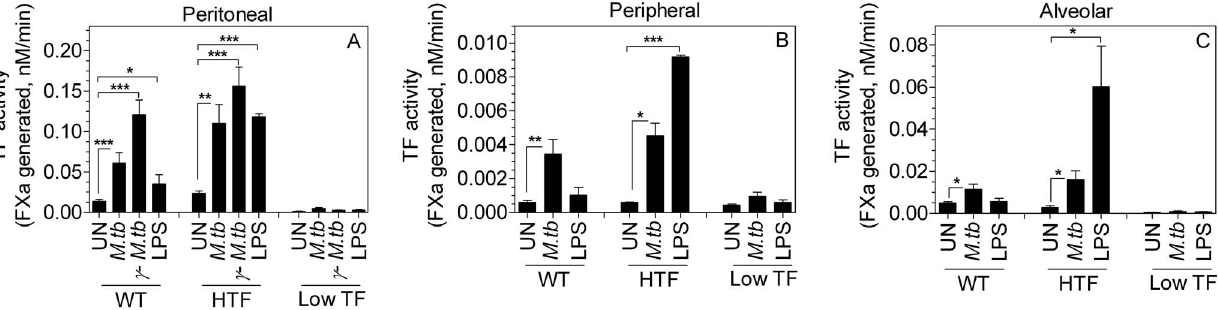
Figure 7. Varied TF expression levels in macrophages derived from different sources in wild-type (WT), HTF and low TF mice in response to M.tb and LPS stimulation. Macrophages ( , 0.5 6 10 5 cells) were either stimulated with live M.tb (10 CFU/cell) or 10 m g/ml of gamma-irradiated M.tb ( c -M.tb ) for overnight in antibiotic free RPMI complete medium. Macrophages were also stimulated with LPS (1 m g/ml) as a positive control for 6 h. At the end of the treatment, TFactivitywasmeasured in FXactivation assay. * denotessignificantly different from unstimulated controls.(* p , 0.05;** p # 0.001;*** p , 0.0001) as obtained by Students t-test. Data are mean ¡ SEM (n 5